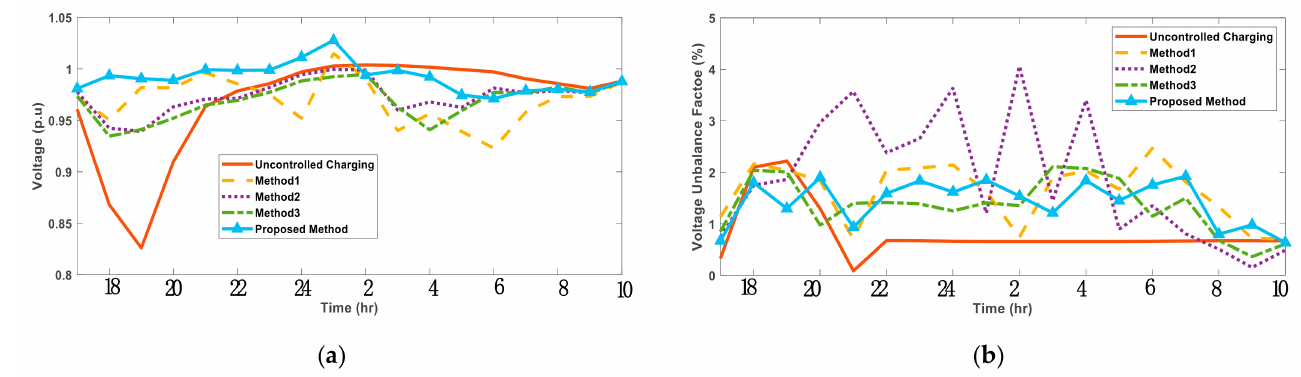
Figure 16. Bus 846 ( a ) voltage and ( b ) VUF for price signals in the summer